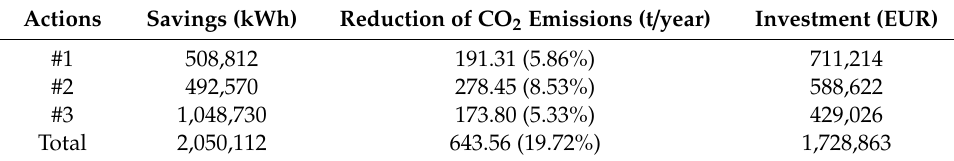
Table 4. Features of the selected actions. The percentages of CO 2 emission reduction are calculated compared to the total CO 2 emission from 25 selected buildings of the Municipality of Potenza (3262.9 t / year).